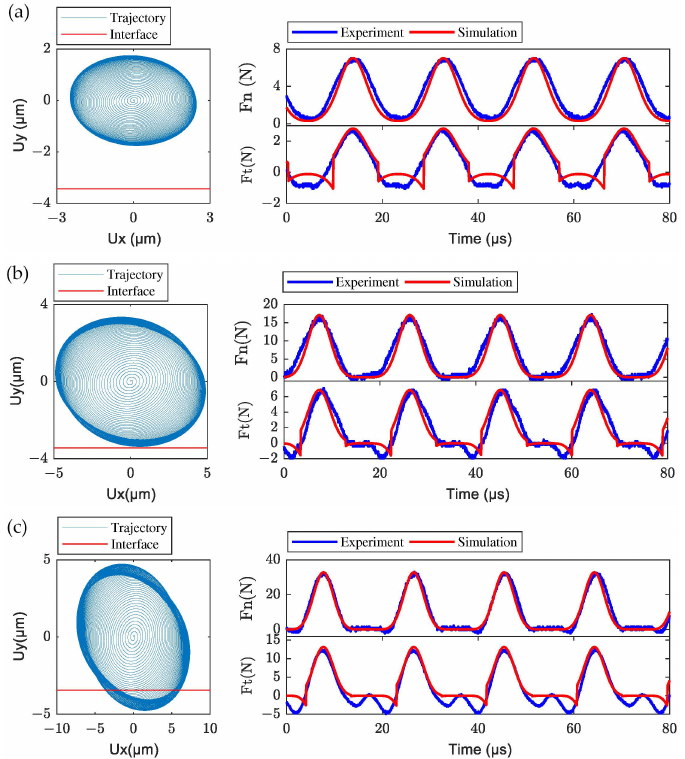
Figure 20. Transient nodal trajectory at the center of the contact tip, and the comparison of frictional contact forces between experiments and simulations for different exciting voltages: ( a ) 50 V, ( b ) 100 V, and ( c ) 150